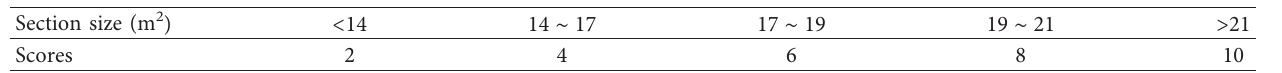
Table 13: The scores of section size.